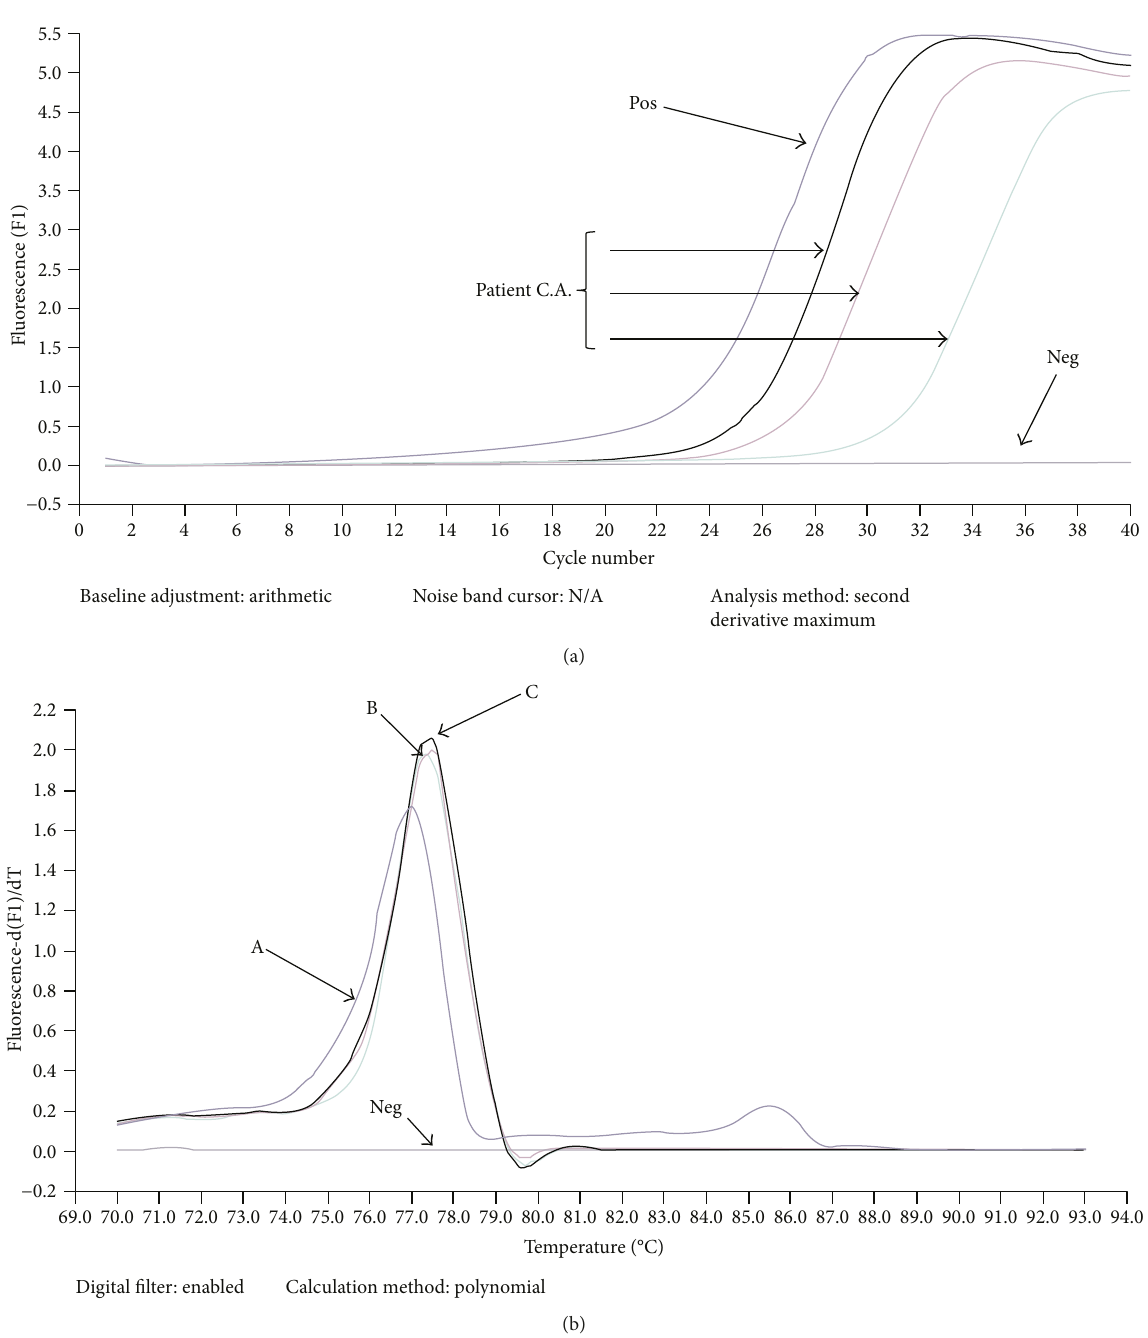
Figure 1: (a) PCR real-time curves obtained from cystic liquid of our patient C.A. following the procedure of Capuano et al. [12] reported in “ Material and Methods ” ; (b) melting curves of hydatid cyst of standard E. granulosus genotypes G1 with Tm 76.55 (A), genotypes G2/G3 with Tm 77.03 (B), and of hydatid cyst of patient C.A. with Tm 77.11 (C) from this study. Neg is a negative